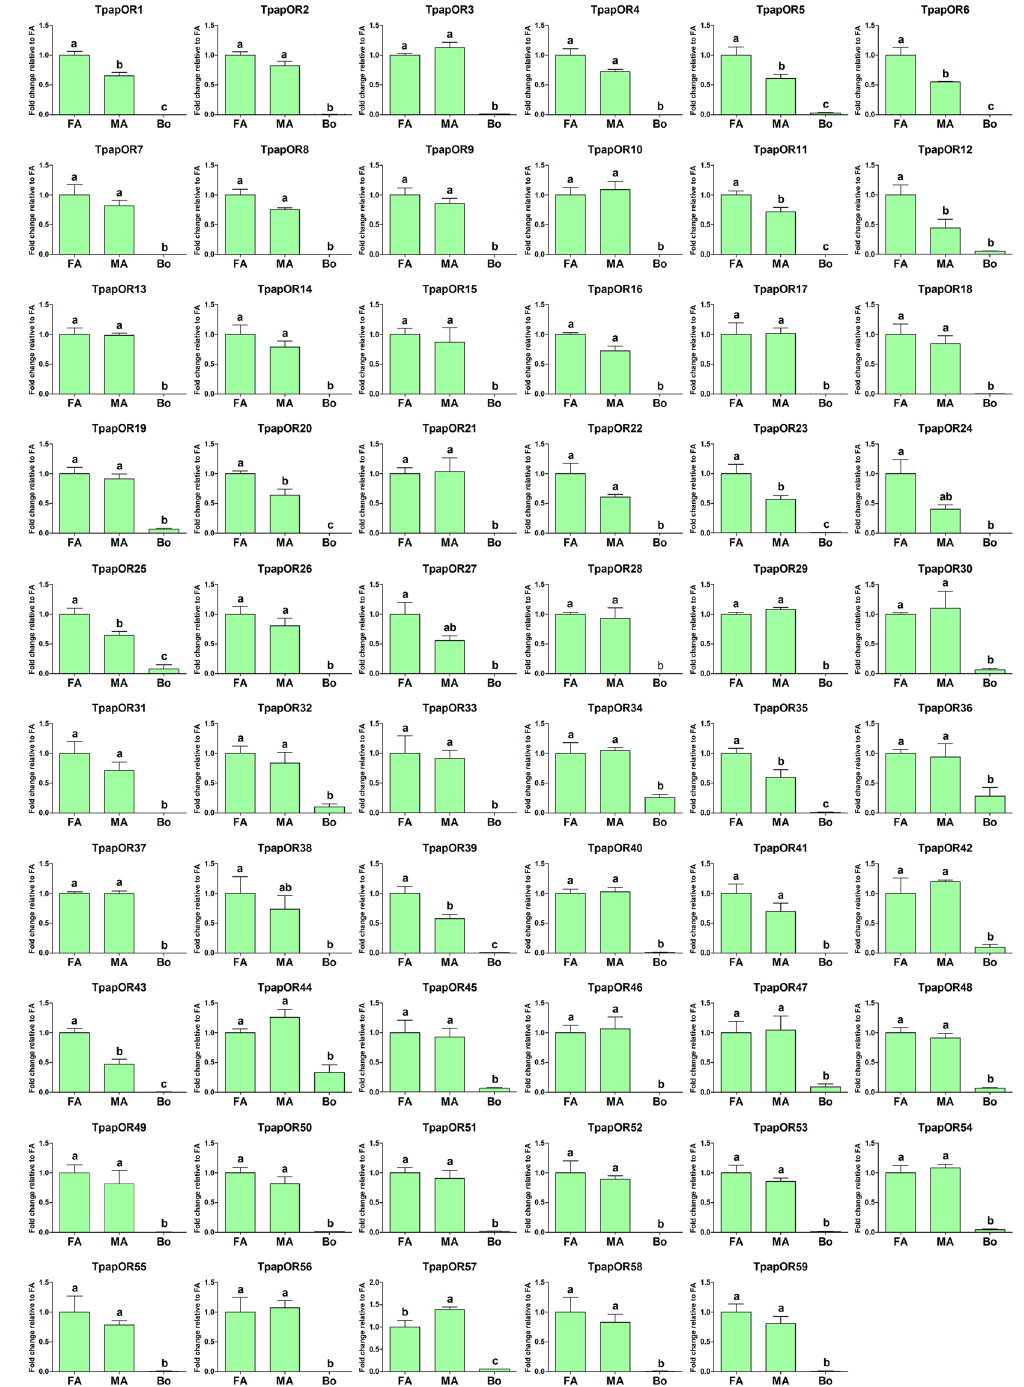
Figure 3. Relative expression levels of putative T . papillosa ORs in the female and male antennae, and other body parts. Abbreviations: FA, female antennae; MA, female antennae; Bo, other body parts (the pooled tissue mixture of proboscis, stink gland, midgut, foreleg tarsus, and wing). The expression levels were estimated using the 2 −ΔΔ CT method. The relative expression level is indicated as mean ± SE (n = 4). Standard error is represented by the error bar, and different letters indicate statistically significant difference between tissues (p < 0.05, ANOVA,